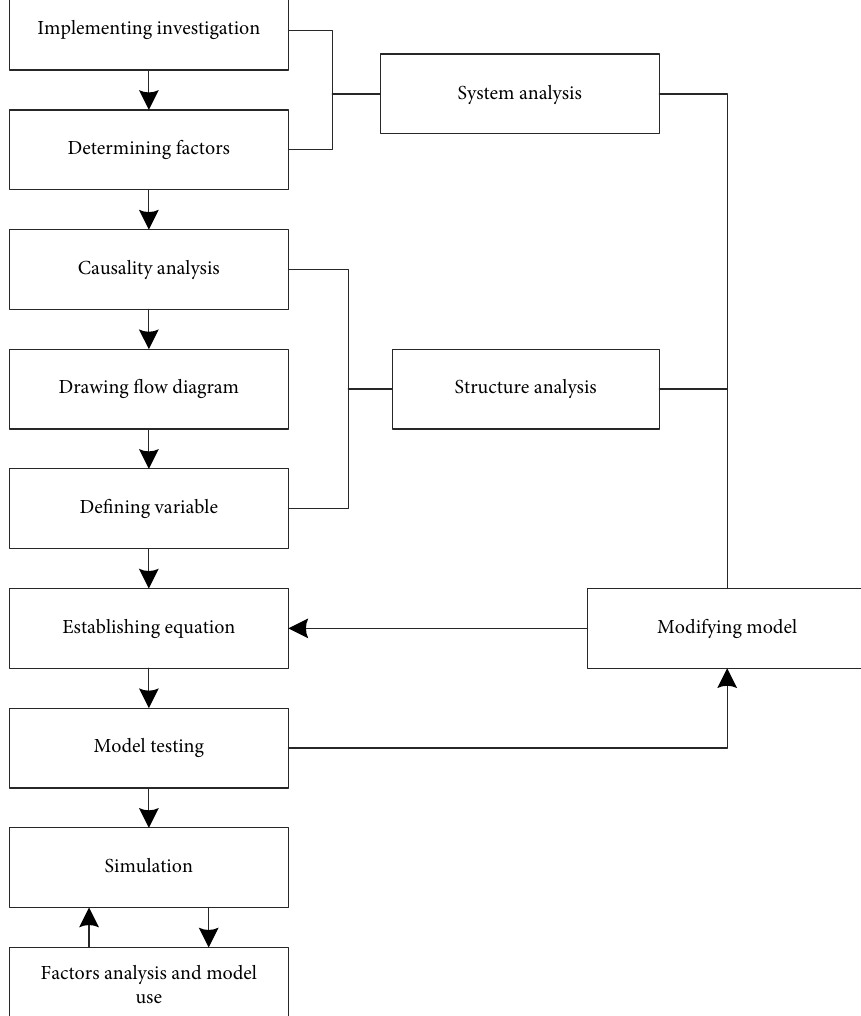
Figure 1: Modeling framework of system dynamics.